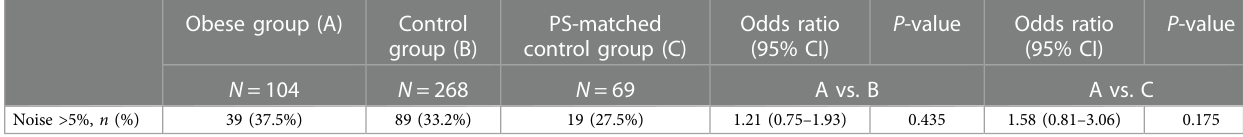
TABLE 3 Number of patients with >5% noise burden on any day within 90 days from insertion and the results of the logistic regression analysis. Obese group